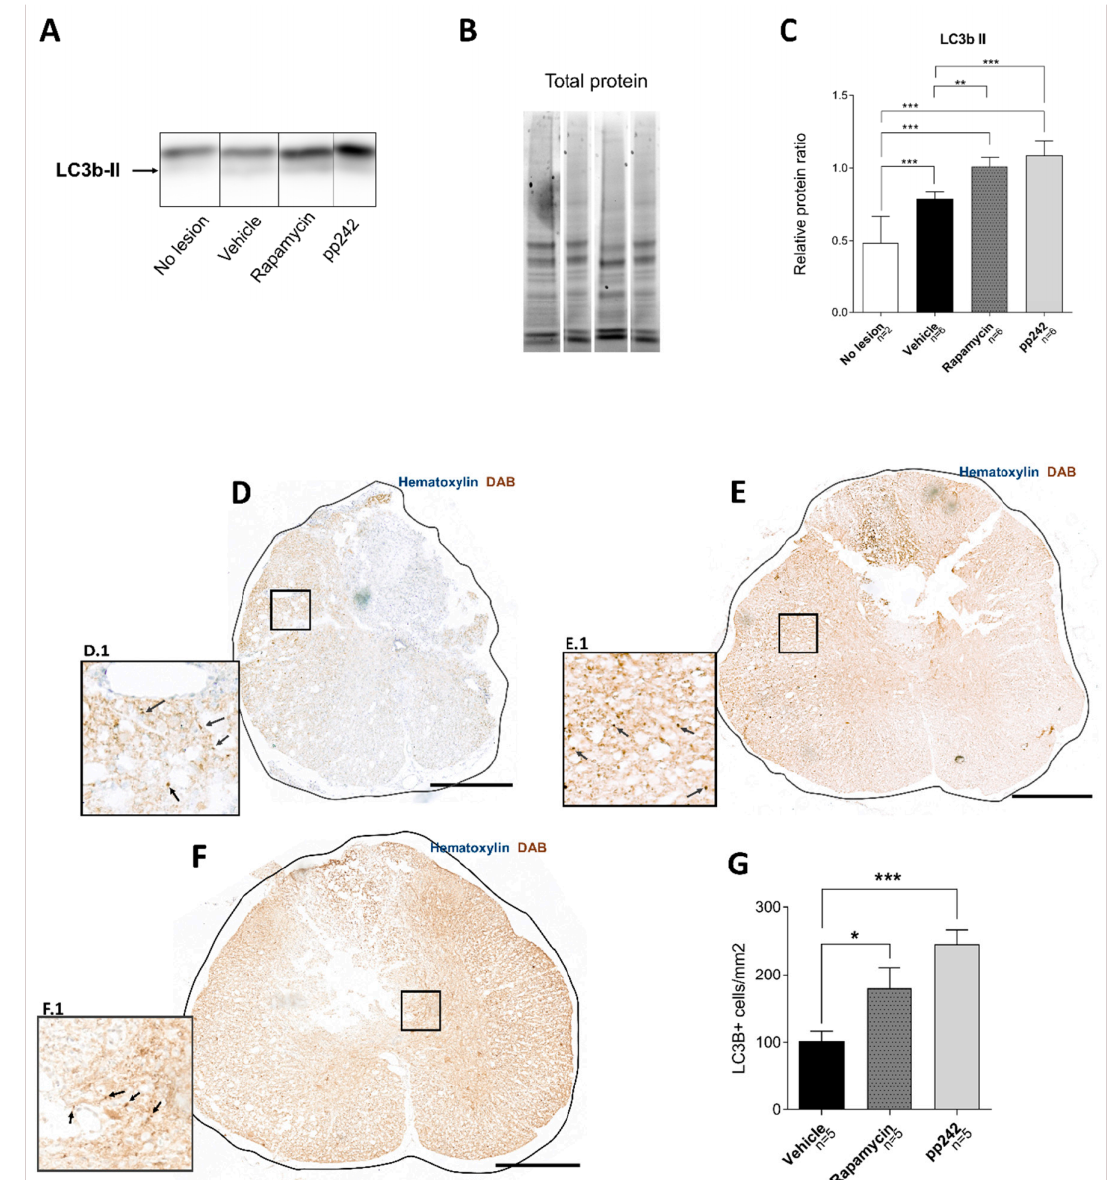
Figure 2. Separation of mTOR pathway by RAPA or pp242 enhances autophagy in SCI. LC3b-II content was assessed by Western blot analyses ( A – C ). Representative immunoblot lanes of each sample group are presented ( A ). Protein band intensities were normalized to total protein content visualized by stain-free technology ( B ). Representative total protein stains are corresponding to the sample lanes in representative immunoblots. LC3b-II levels were higher in all injured rats compared to non-injured rats; however, significantly higher levels were present in animals treated with RAPA or pp242 compared to vehicle-treated controls ( C ). Immunohistochemical analysis of LC3b in spinal cord sections from rats treated with vehicle control ( D ), RAPA ( E ), or pp242 ( F ) revealed a significant increase in LC3b expression in both RAPA- and pp242-treated groups ( G ). Scale bars: 500 µ m; D.1, E.1, and F.1 images are 1:4 magnifications of corresponding areas of the spinal cord. Arrows point to examples of DAB-stained cells. Data are shown as means ± SEM; * p < 0.05, ** p < 0.01, *** p <